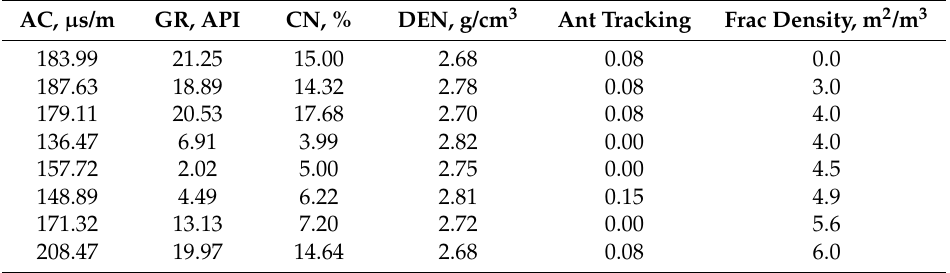
Table 4. Core observed fracture density and the corresponding wireline log values and ant attribute. AC, µ s/m GR, API CN, % DEN, g/cm 3 Ant Tracking Frac Density, m 2 /m 3